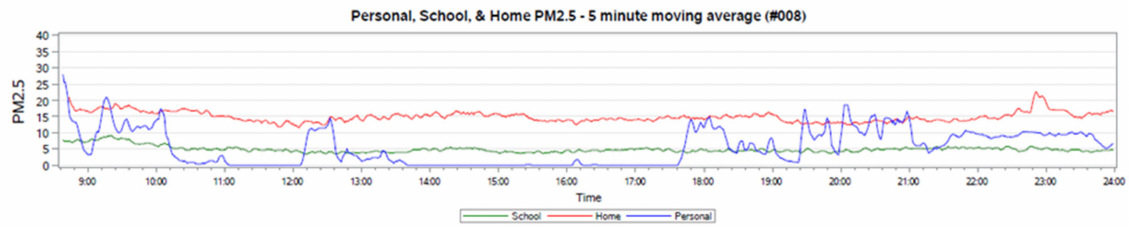
Figure 5. Time-series plot of PM2.5 data, averaged using a 5-min moving average. Data are included for air sensors from personal, home, and school monitors for participant #008. Table 4. Descriptive statistics for participant #008. n is the number of observations, which were recorded for each minute. Min, max, mean, and median are all units of ug / m3. Home PM2.5 Personal PM2.5 School PM2.5 n 909 912 914 minimum 10 0 3 maximum 25 29 10 mean 14.92 5.47 4.91 median standard dev.